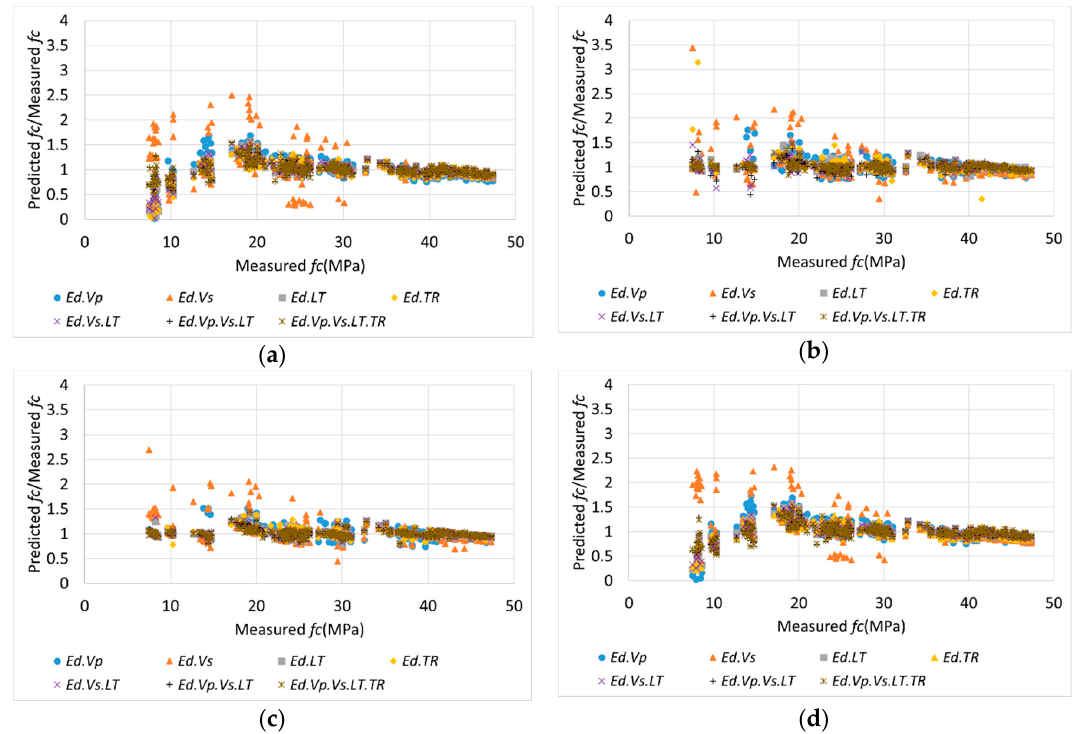
Figure 16. Relationship between the measured Ec and the ratio of predicted fc to measured fc using the four ML methods. ( a ) SVM; ( b ) ANN; ( c ) Ensemble; ( d ) LR.